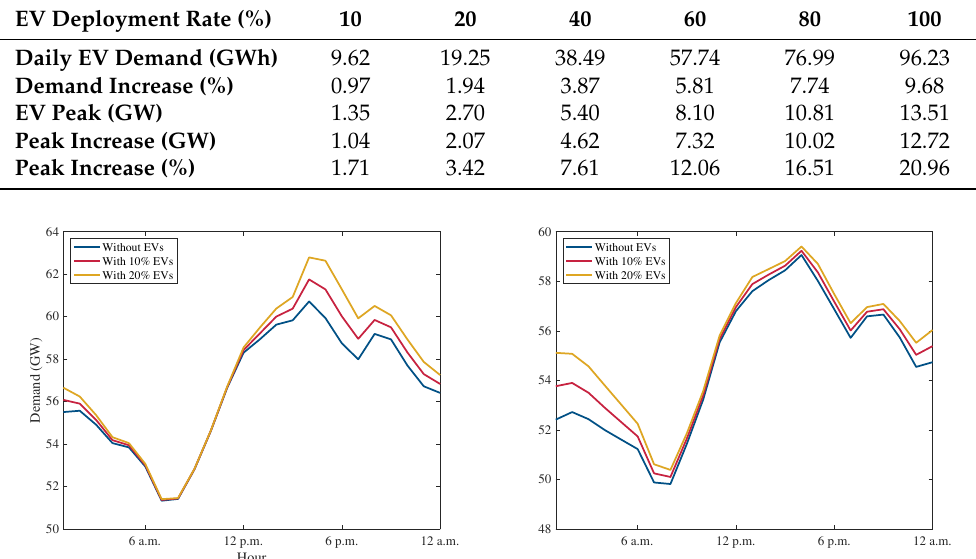
Table 4. Expected impact of EV’s on KSA system with 10 millions active car.